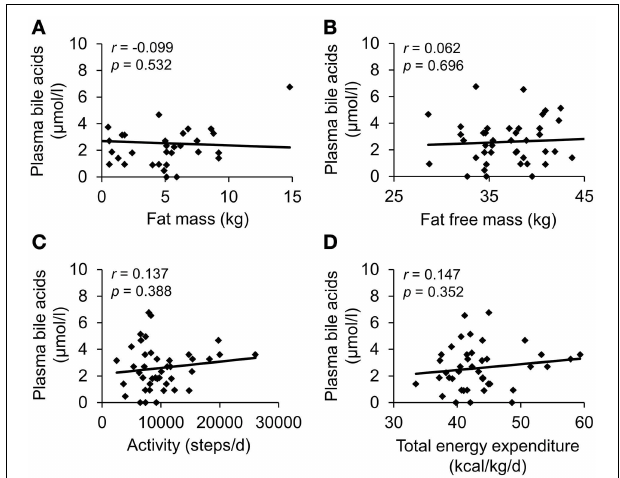
FIGURE 2 | Plasma bile acids do not show a correlation with body composition or energy expenditure in patients with anorexia nervosa. The study population consisted of 43 anorexic subjects with broad activity pattern. Body composition was assessed using bioelectrical impedance analysis; physical activity was monitored with a portable armband device. No correlation was observed between plasma bile acids and fat mass (A) , fat free mass (B) , physical activity expressed as steps/d (C) and total energy expenditure (D) . Values for r and p are indicated in the correlation graphs.